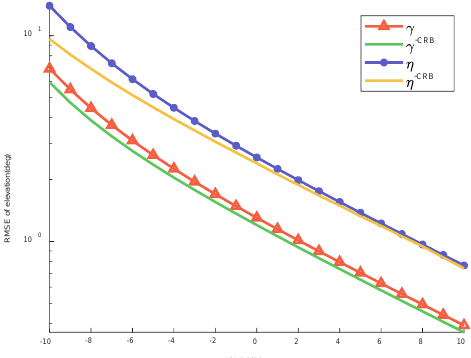
Figure 5. RMSE of elevation with respect to the SNR of the two-polarization parameters and their CRBs using the P-SSV-MUSIC algorithm.